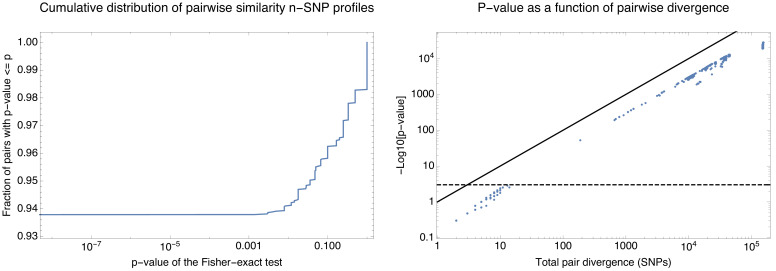
Statistical significance of the difference in n-SNP statistics for all pairs of strains. Left panel: Cumulative distribution of the p-values of the Fisher exact test (Materials and methods) for the n-SNP statistics across all pairs of strains. About 94% of all pairs have significantly different n-SNP distributions. Right panel: p-values of the Fisher-exact test as a function of the divergence of each pair of strains. Each dot corresponds to one pair with the horizontal axis showing the total number of single-nucleotide differences between the pair of core genomes and the vertical axis showing minus the logarithm of the p-value (base 10). The diagonal line corresponds to the line y=x and the horizontal dashed line corresponds to a p-value of 0.001. Note that the significance correlates very well with the divergence of the pair and that only pairs of genomes that differ in less than 10 nucleotides in their core genomes have indistinguishable n-SNP statistics.